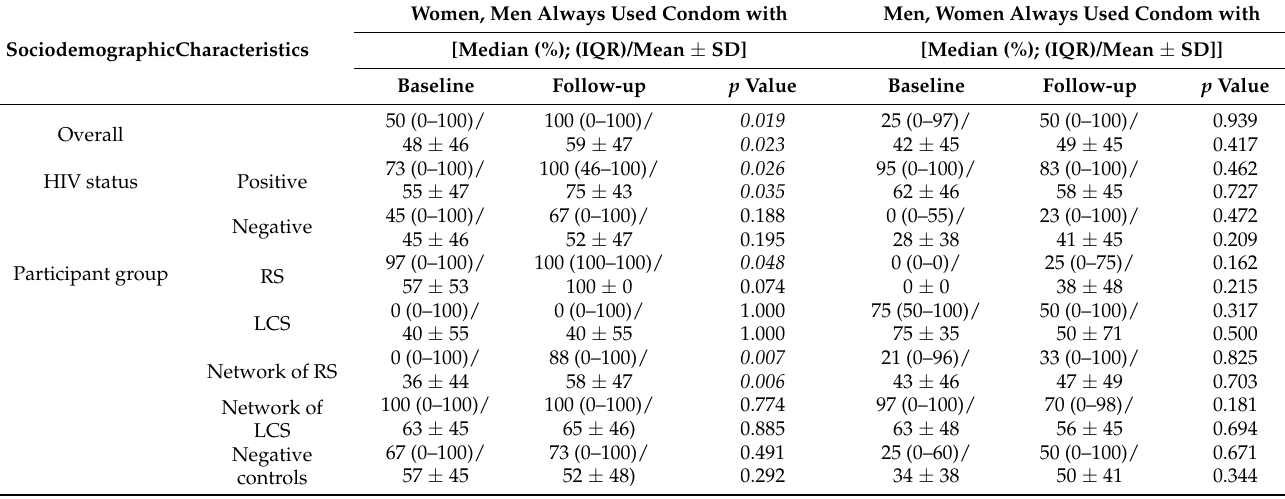
The Wilcoxon signed-rank test was used to test the difference of the matched pairs at baseline versus follow-up. p Values in italics stand for statistically significant differences between groups ( p < 0.05). Abbreviations: HIV, human immunodeficiency virus; IQR, Interquartile range; SD, standard deviation; RS, recent seeds; LCS, control seeds with long-term HIV infection.